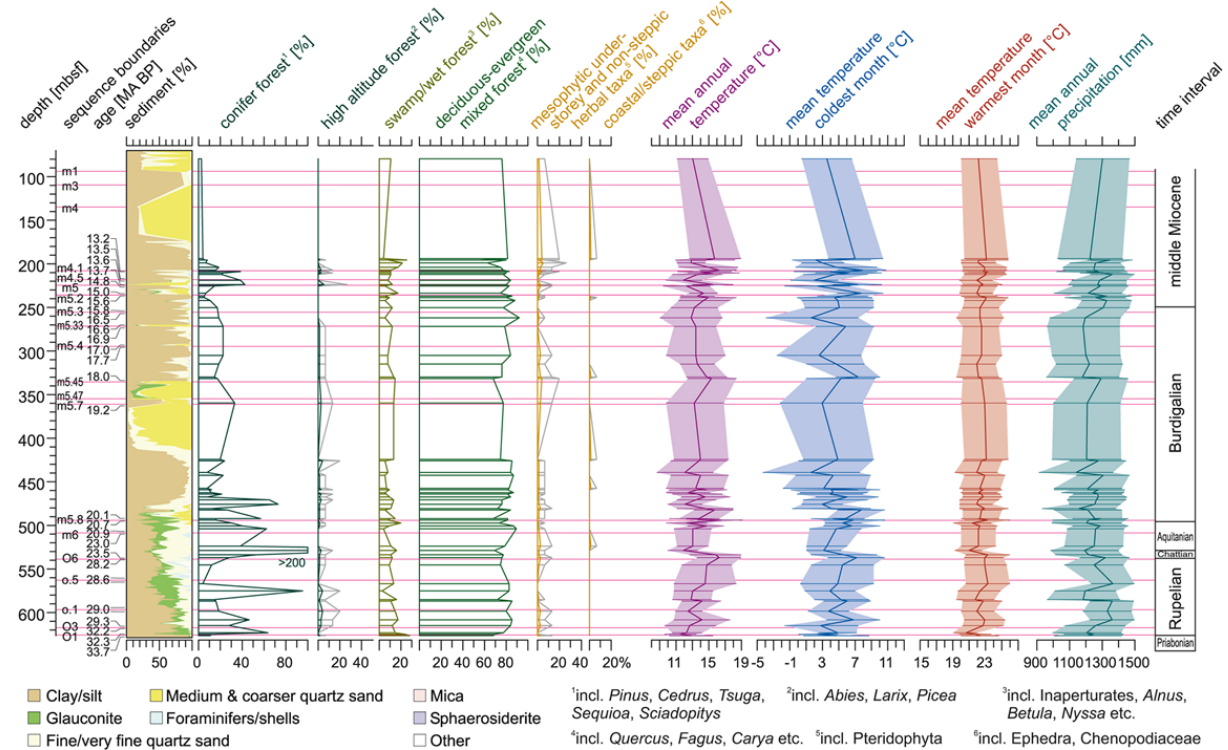
Figure 3. Lithology, palynological results, and pollen-based climate results for Site M0027. Shown versus depth: lithology, sequence bound- aries, pollen percentages integrated into vegetation types (percentages are based on the sum of non-saccate pollen), pollen-based quantitative climate data, time intervals. Sequence ages are based on Browning et al.